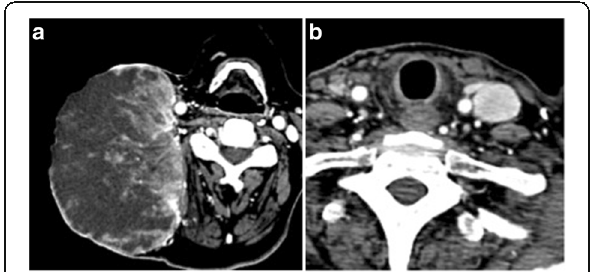
Fig. 5 A case of 67 years old of nodal recurrence from previous de- differentiated thyroid carcinoma. A very huge invasive node on right side with marked necrosis ( a ); essentially not central and very thick hyper-enhancing irregular margin and small non-necrotic IV node on left side ( b ), showing moderate to very hyper-enhancement